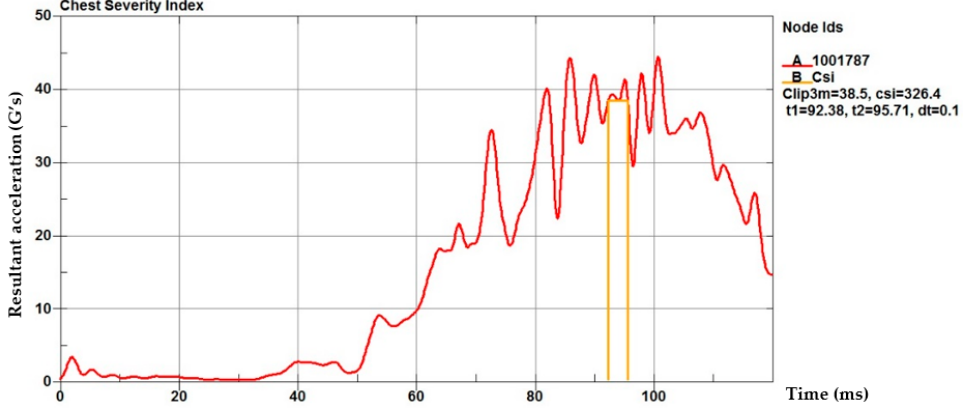
Figure 10. Chest deflection of the dummy in the armored vehicle.